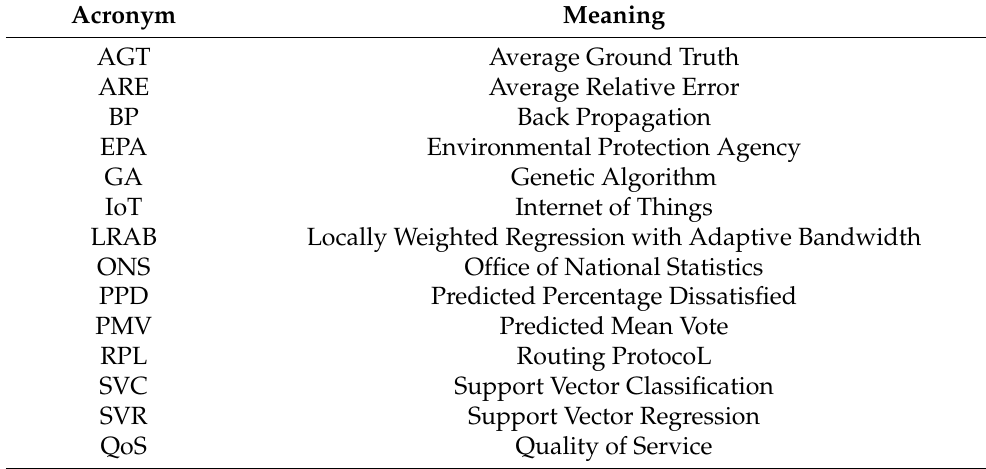
Table 2. List of